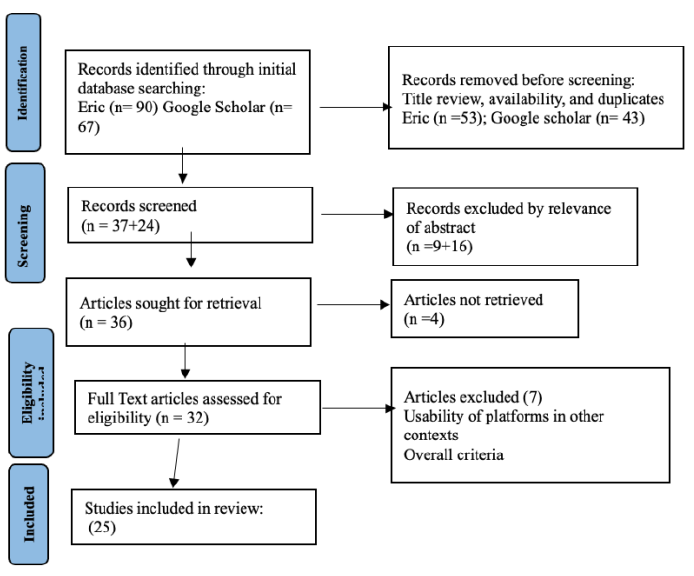
Figure 3: Process followed to obtain studies